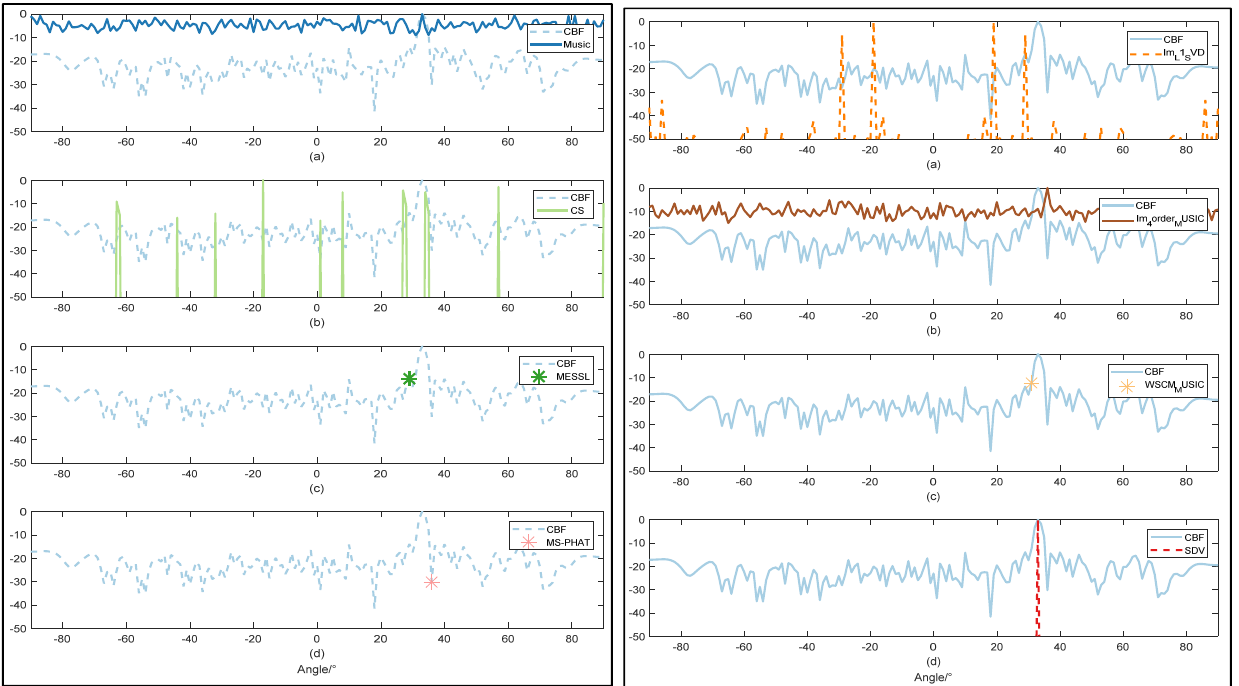
Figure 7. Comparison of direction estimation with SNR 1 = − 10 dB by 9 methods: CBF worked as a comparison in all figures. Music are shown in left ( a ) CS are shown in left ( b ). MESSL are shown in left ( c ) and MS-PHAT are shown in left ( d ). Im-L1-SVD are shown in right ( a ). Im-4order-MUSIC are shown in right ( b ). WSCM-MUSIC are shown in right ( c ) and proposed SDV are shown in right ( d